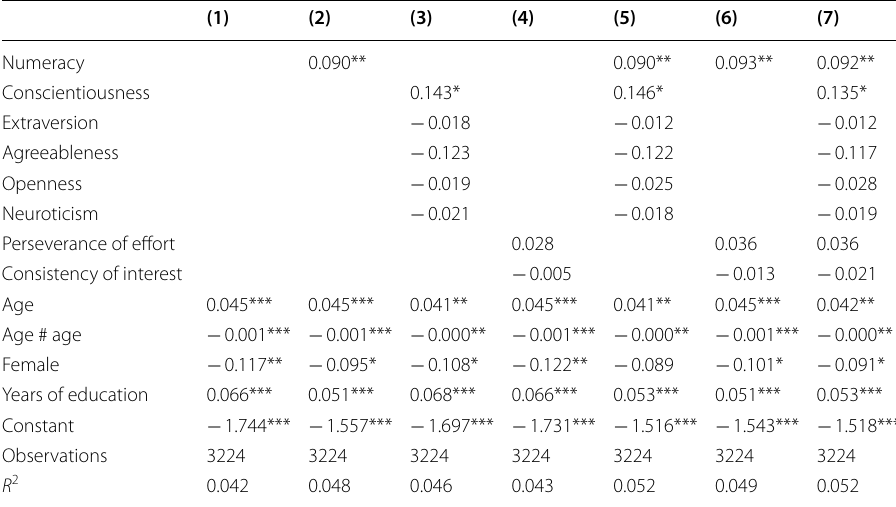
Table 12 Self-declared employability and cognitive and non-cognitive